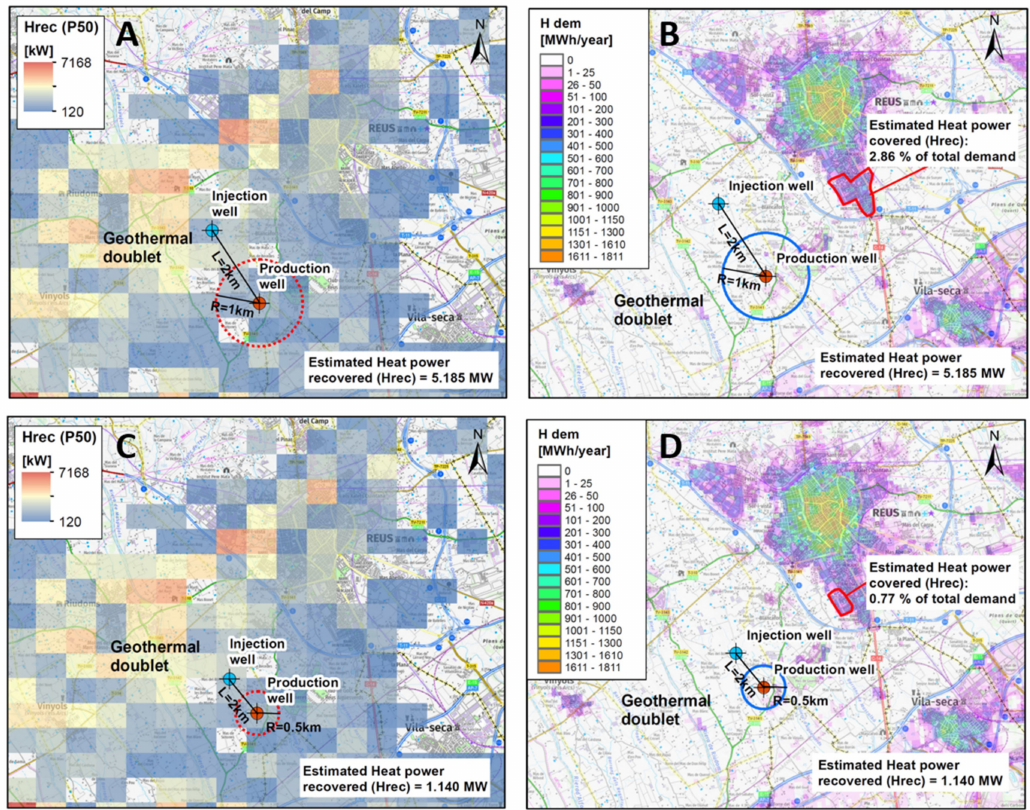
Figure 12. Two geothermal doublet scenarios comparing the Hrec_P50 ( A – C ) with the heat demand of the city of Reus ( B – D ): the red polygon shows the covered area of the Reus total demand. ( A , B ) The injection and production wells are separated by 2 km and the radius of influence into the reservoir is considered to be 1 km. ( C , D ) The injection and production wells are separated by 1 km and the well influence radius into the reservoir is 0.5